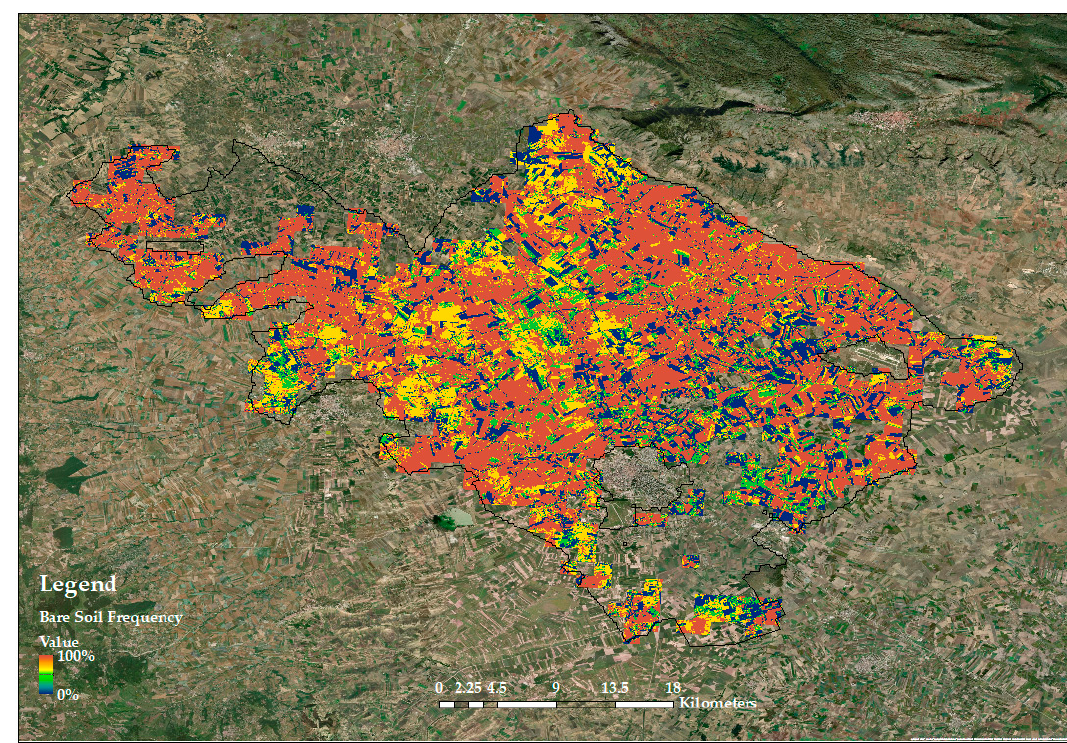
Figure 9. Bare soil frequency map of the Capitanata region for the month of September, average over the four years of data.